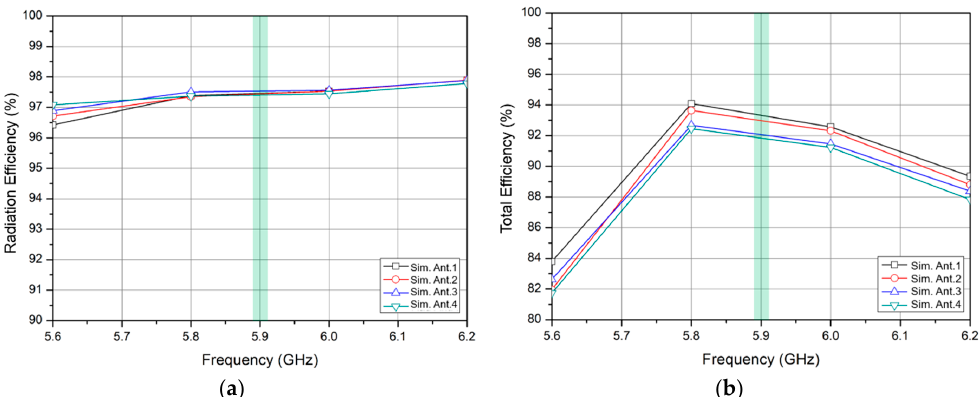
Figure 8. Simulated ( a ) radiation efficiency and ( b ) total efficiency.